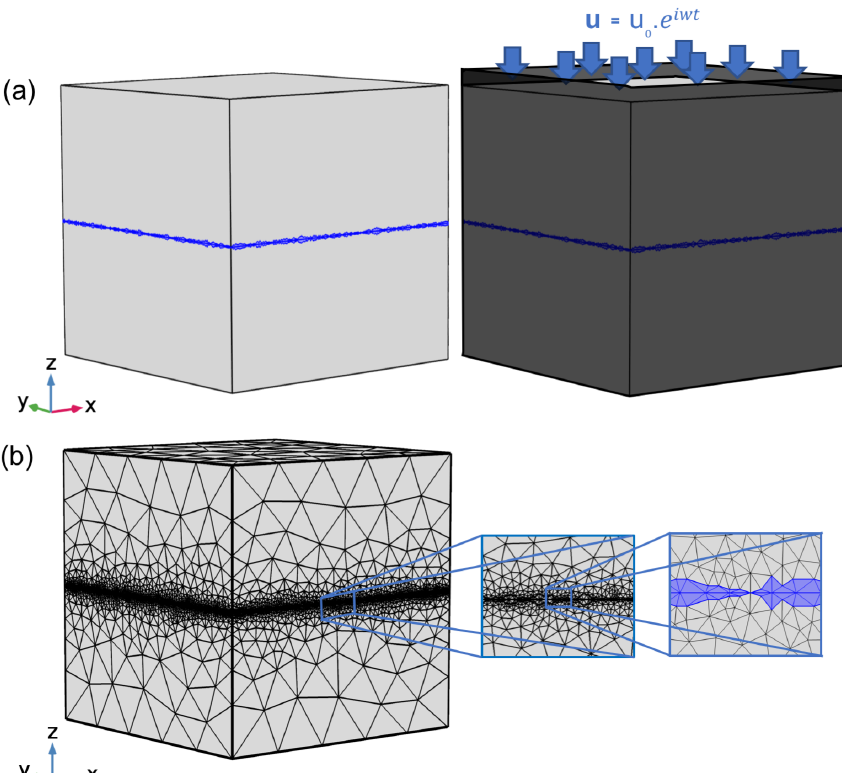
Figure 1. (a) REV (left) and oscillatory relaxation test, in which no normal solid displacements are allowed at the laterals and bottom of the numerical model and a vertical displacement is applied at the top of the model (right). (b) Tetrahedral meshing of the numerical